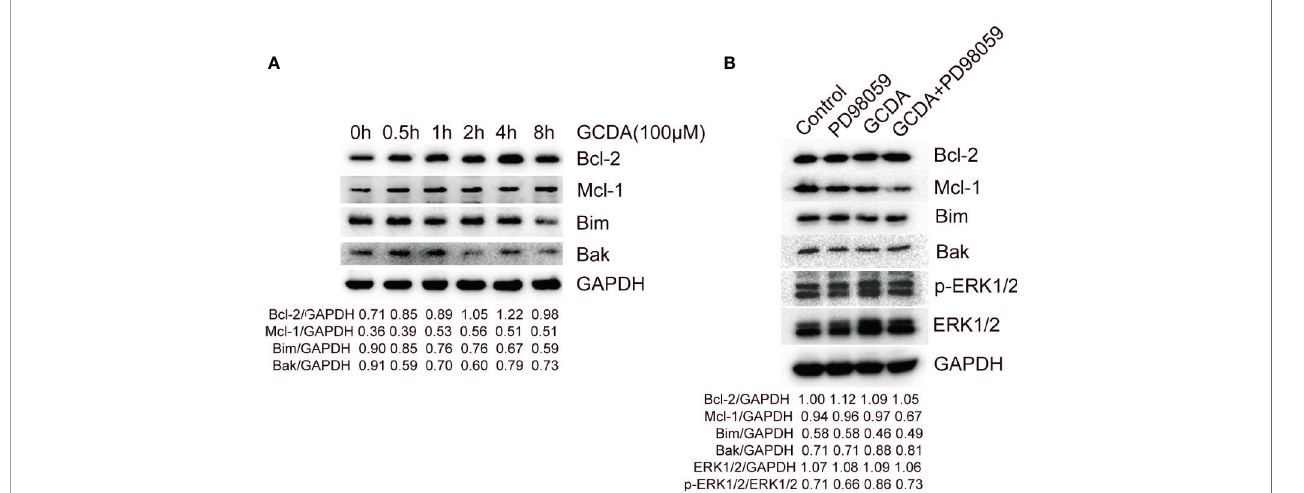
FIGURE 5 | PD98059 suppresses GCDA-stimulated increase of Mcl-1 and decrease of Bim. (A) 100 m M GCDA was used to treat QGY-7703 cells for 0h, 0.5h, 1h, 2h, 4h and 8h. Expression of Bcl-2, Mcl-1, Bim and Bak was tested by western blot and quanti fi ed by Alphaview software. (B) QGY-7703 cells were preincubated with 10 m M PD98059 for 0.5 h, followed by treatment with 100 m M GCDA for 8h. All cell extracts were analyzed using Bcl-2, Mcl-1, Bim, Bak, p-ERK1/2 and ERK1/2 antibodies by Western blotting and quanti fi ed by